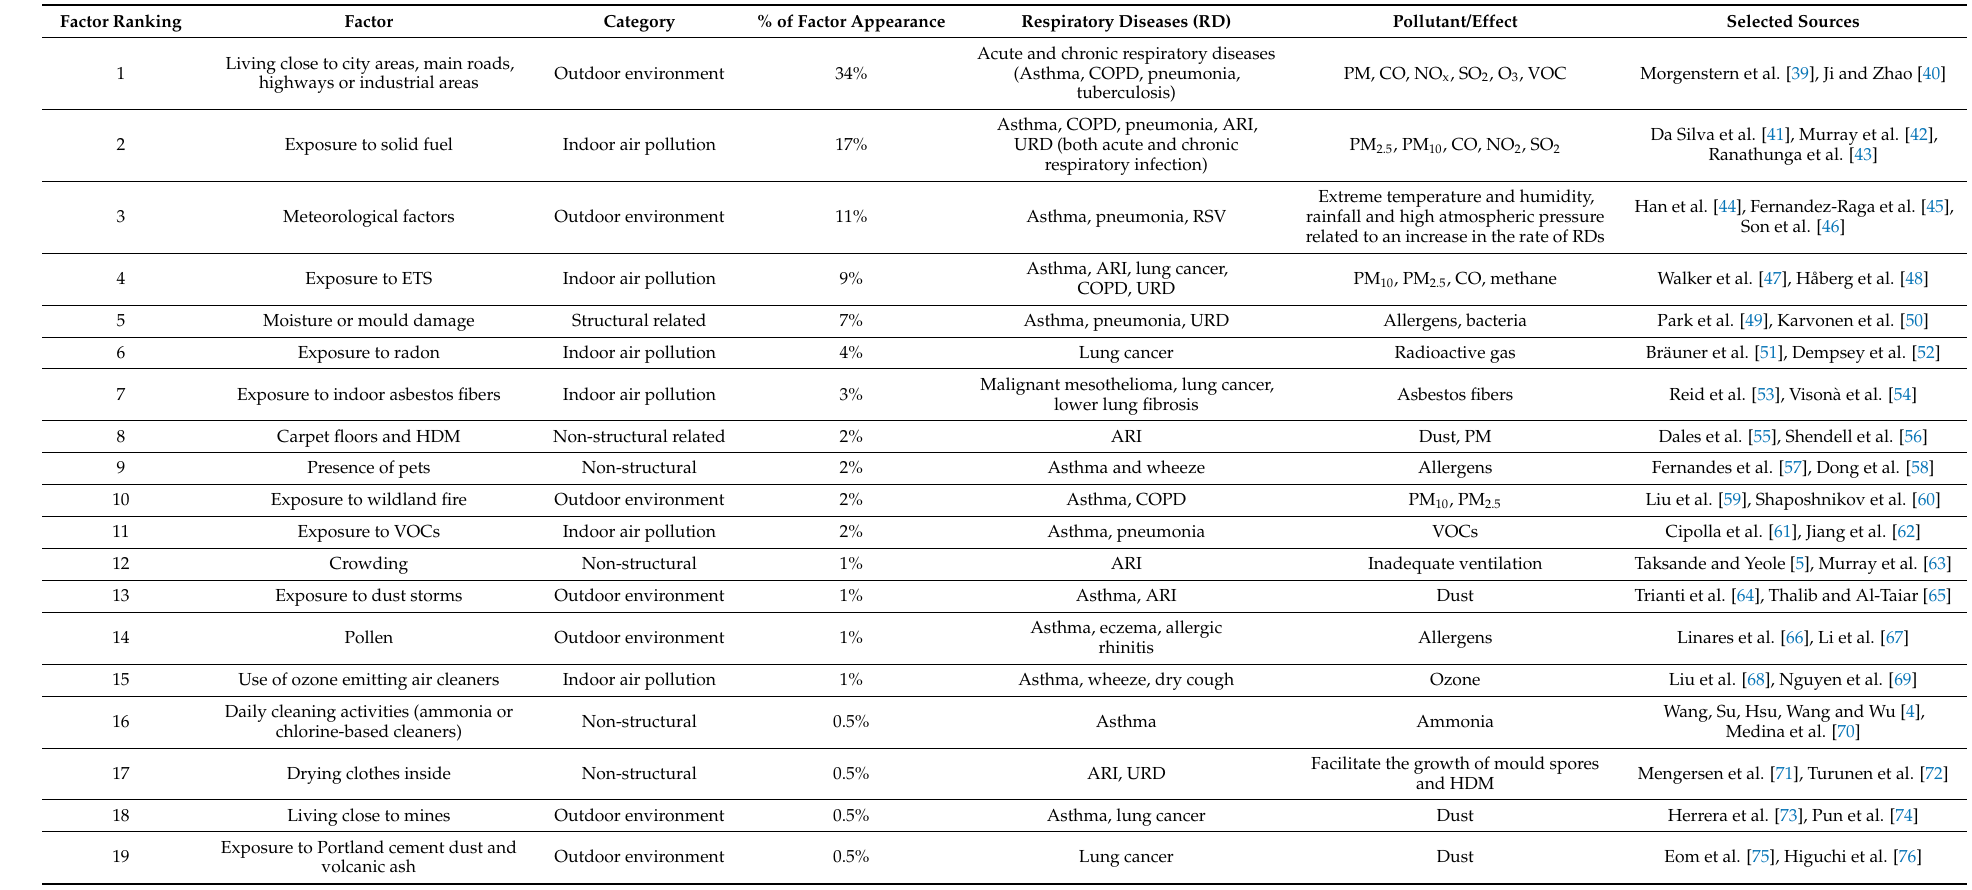
Table 2. Summary of the reviewed